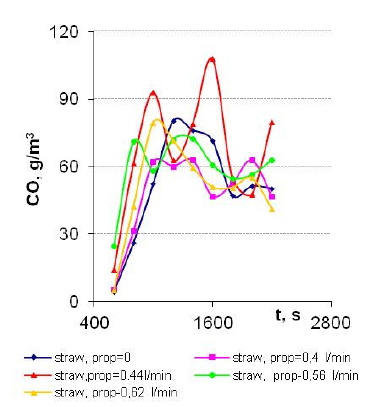
Figure 6. Effect of the propane supply on the H 2 concentration at the bottom of the